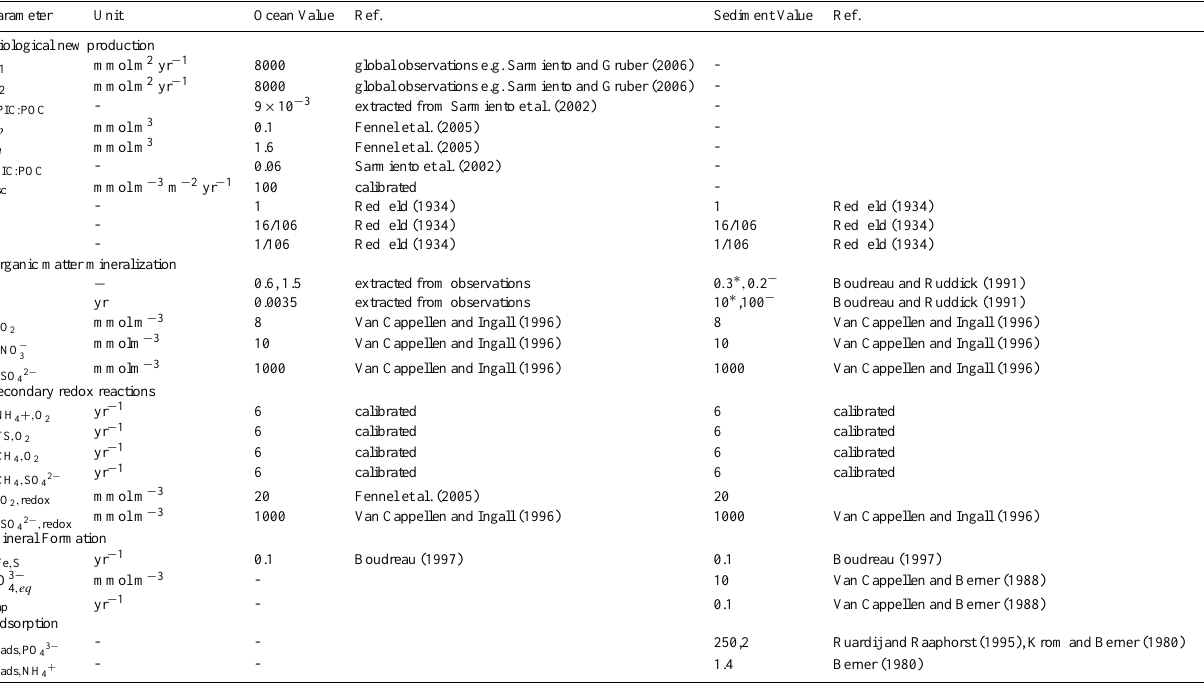
Table 8. Rate constants used in the pelagic and benthic biogeochemical models. . ∗ epicontinental sediments, . − deep sea sediments Parameter Unit Ocean Value Ref. Sediment Value